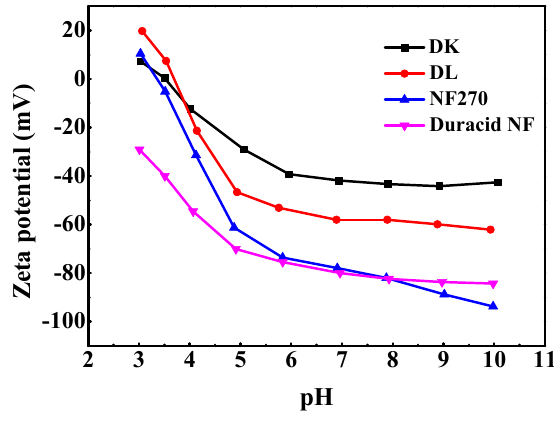
Figure 4. Zeta potential of four NF membranes.